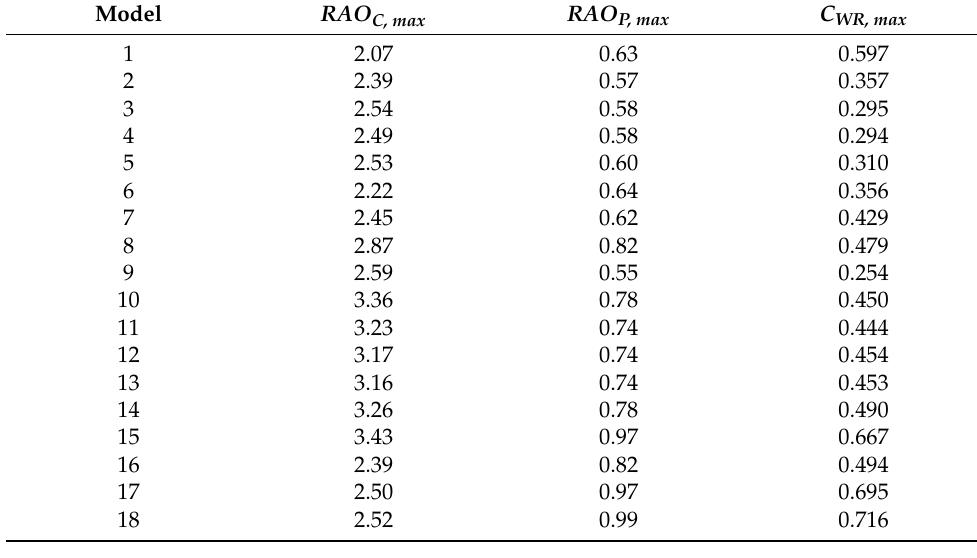
Table 1. Maximum values of (i) the response amplitude operator of the oscillations of the water col- umn inside the chamber ( RAO C ), (ii) and the response amplitude operator of the pressure oscillations ( RAO P ), and (iii) the capture width ratio ( C WR ), for the different OWC geometries tested ( H = 1 m).